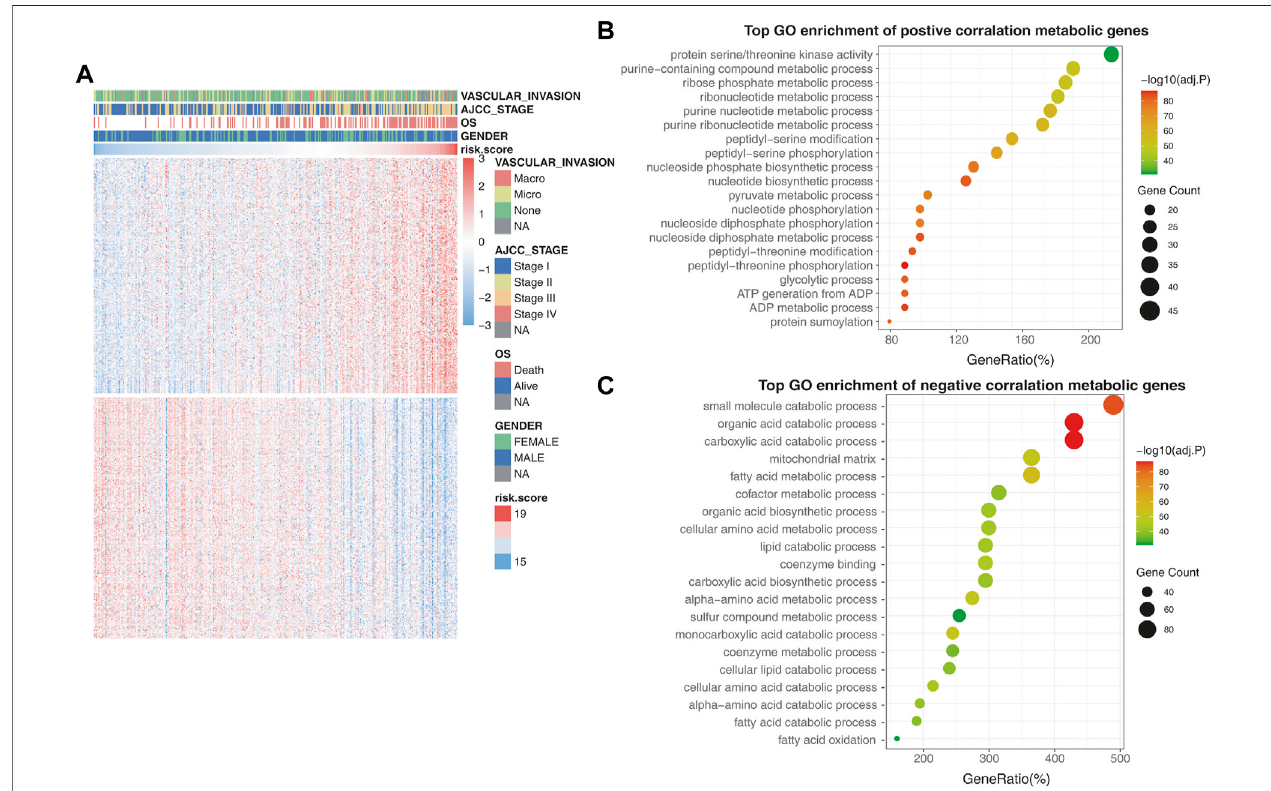
FIGURE 5 | Validating the metabolic rearrangements associated with the prognostic model. (A) Differentially metabolic genes in the high-risk group and low-risk group. The heatmap shows that tumor stage and OS were positively correlated with the risk score, while vascular invasion and gender had no relationship with the risk score. (B) GO enrichment analysis of the metabolic genes that are positively correlated with risk scores. (C) GO enrichment analysis of the metabolic genes that are negatively correlated with risk